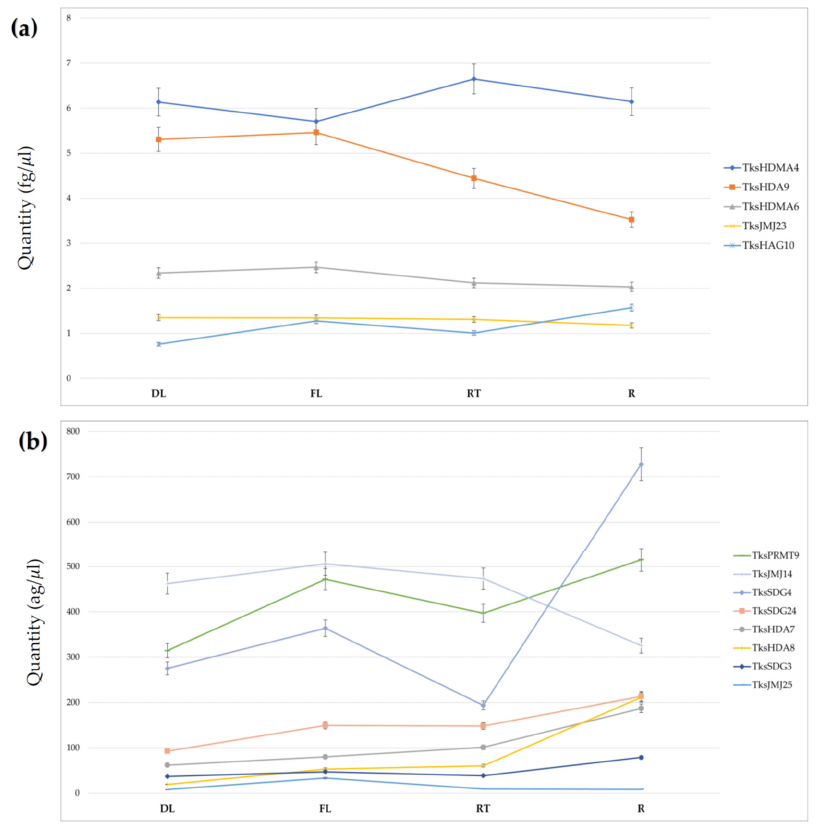
Figure 7. qPCR expression analysis of 13 HM genes in Taraxacum kok-saghyz developing leaves (DL), fully developed leaves (FL), root tips (RT), and mature roots (R). ( a ) Absolute quantification (mean ± SD fg/ μ L) of HM genes with an average expression above 1 fg/ μ L; ( b ) Absolute quantification (mean ± SD ag/ μ L) of HMG genes with an average expression below 1 fg/ μ L.